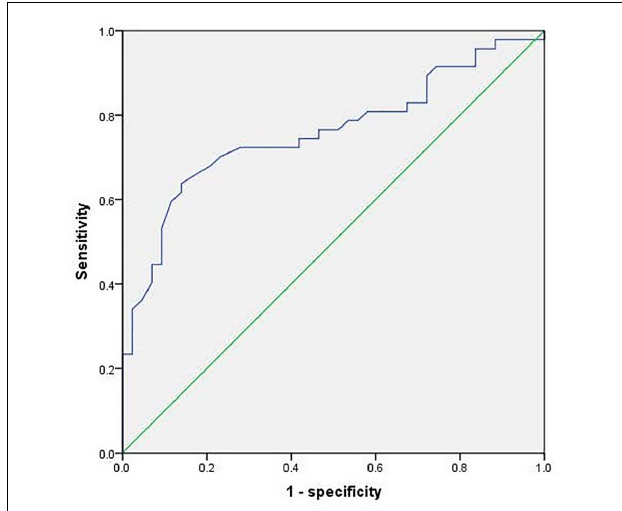
FIGURE 4 | ROC curve of AST/ALT ratio to predict aMCI (cohort 3). AST, aspartate aminotransferase; ALT, Alanine aminotransferase.